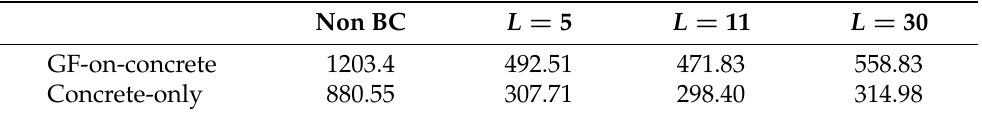
Table 1. RMSME averages of the proposed algorithm according to the number of Gaussian